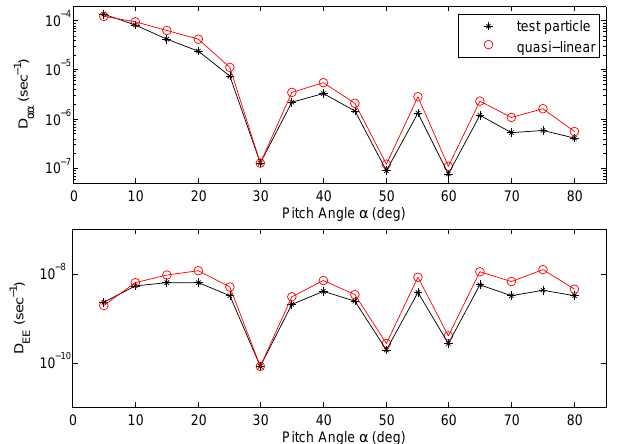
Figure 10. Same as Fig. 9, but the wave frequency is fixed as 1.5kHz, and the resonant latitude vary with initial electron pitch angle to satisfy the N = 1 resonance